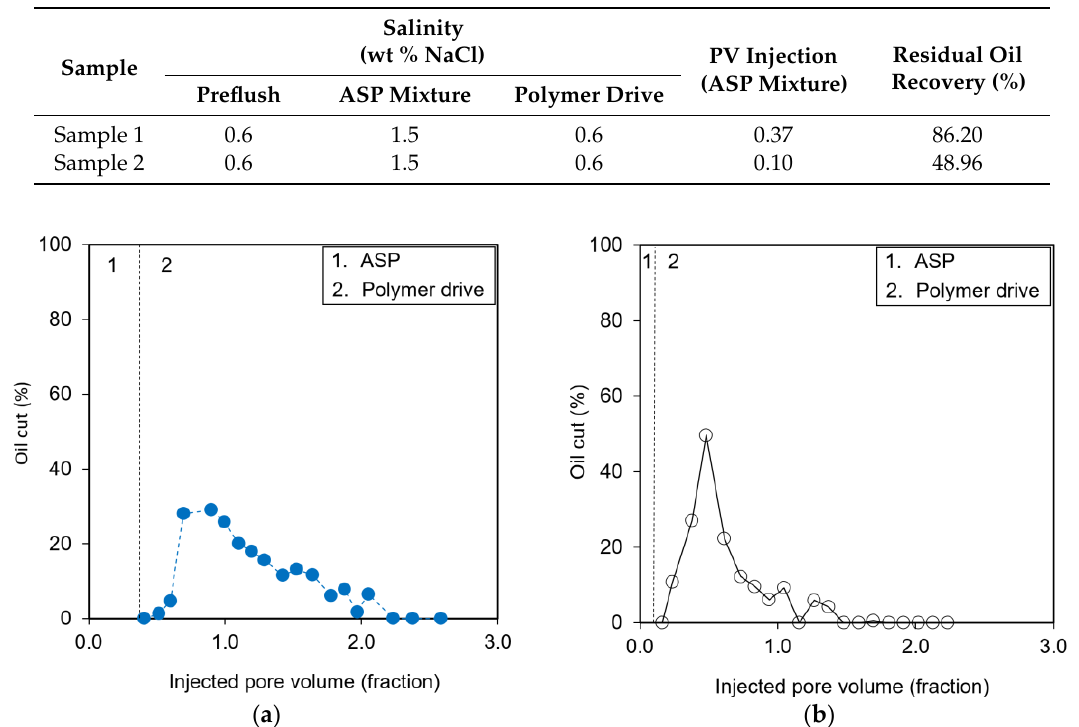
Table 6. Designs of the optimal ASP flooding and their residual oil recoveries.